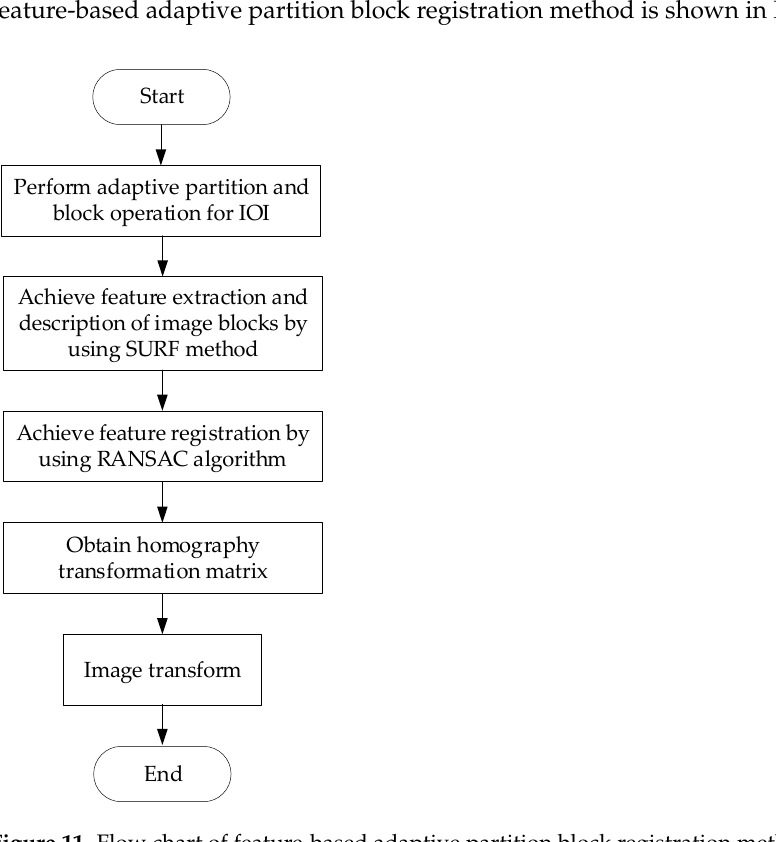
Figure 11. Flow chart of feature-based adaptive partition block registration method.